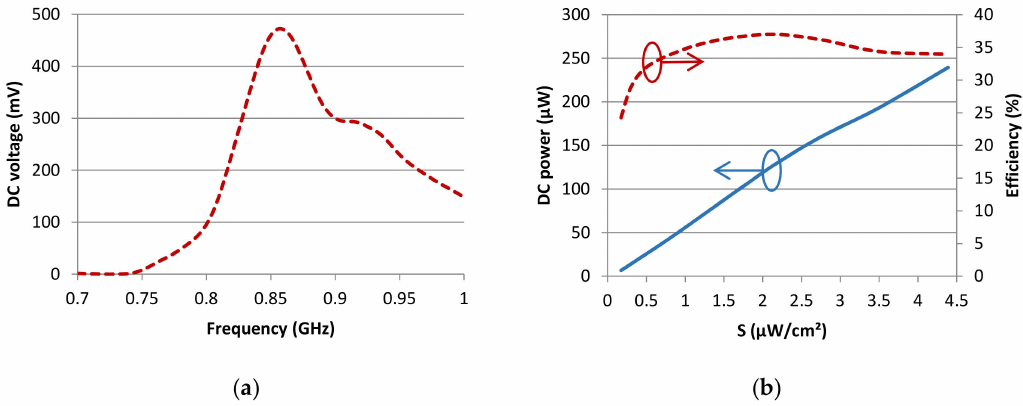
Figure 3. ( a ) Measured DC voltage as a function of the frequency with 10 k Ω load (see [13]); ( b ) Rectenna harvested DC power (continuous curve) and radiofrequency (RF)-to-DC e ffi ciency (dashed curve) at 860 MHz with a 10 k Ω load as a function of the incident RF power density S (from [15]).